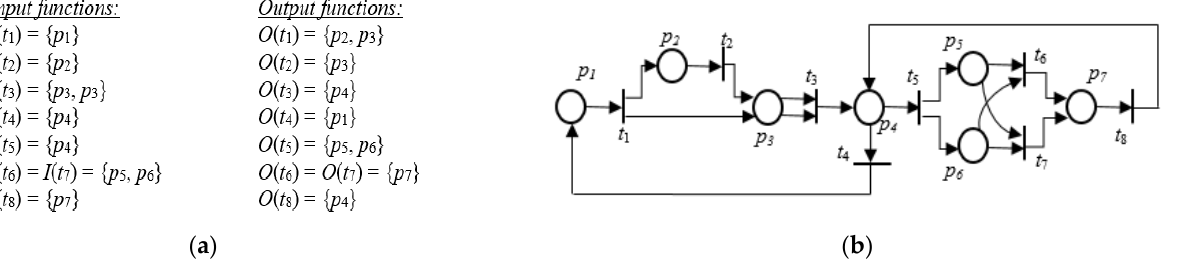
Figure 3. Definition of the proposed PN-model. ( a ) Analytical definition; ( b ) graph presentation of the PN-model.